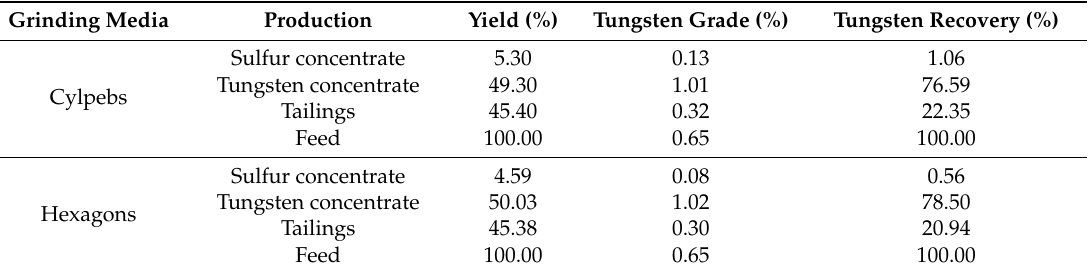
Figure 15. Flotation tests flowsheet. Table 3. The flotation experiment result.